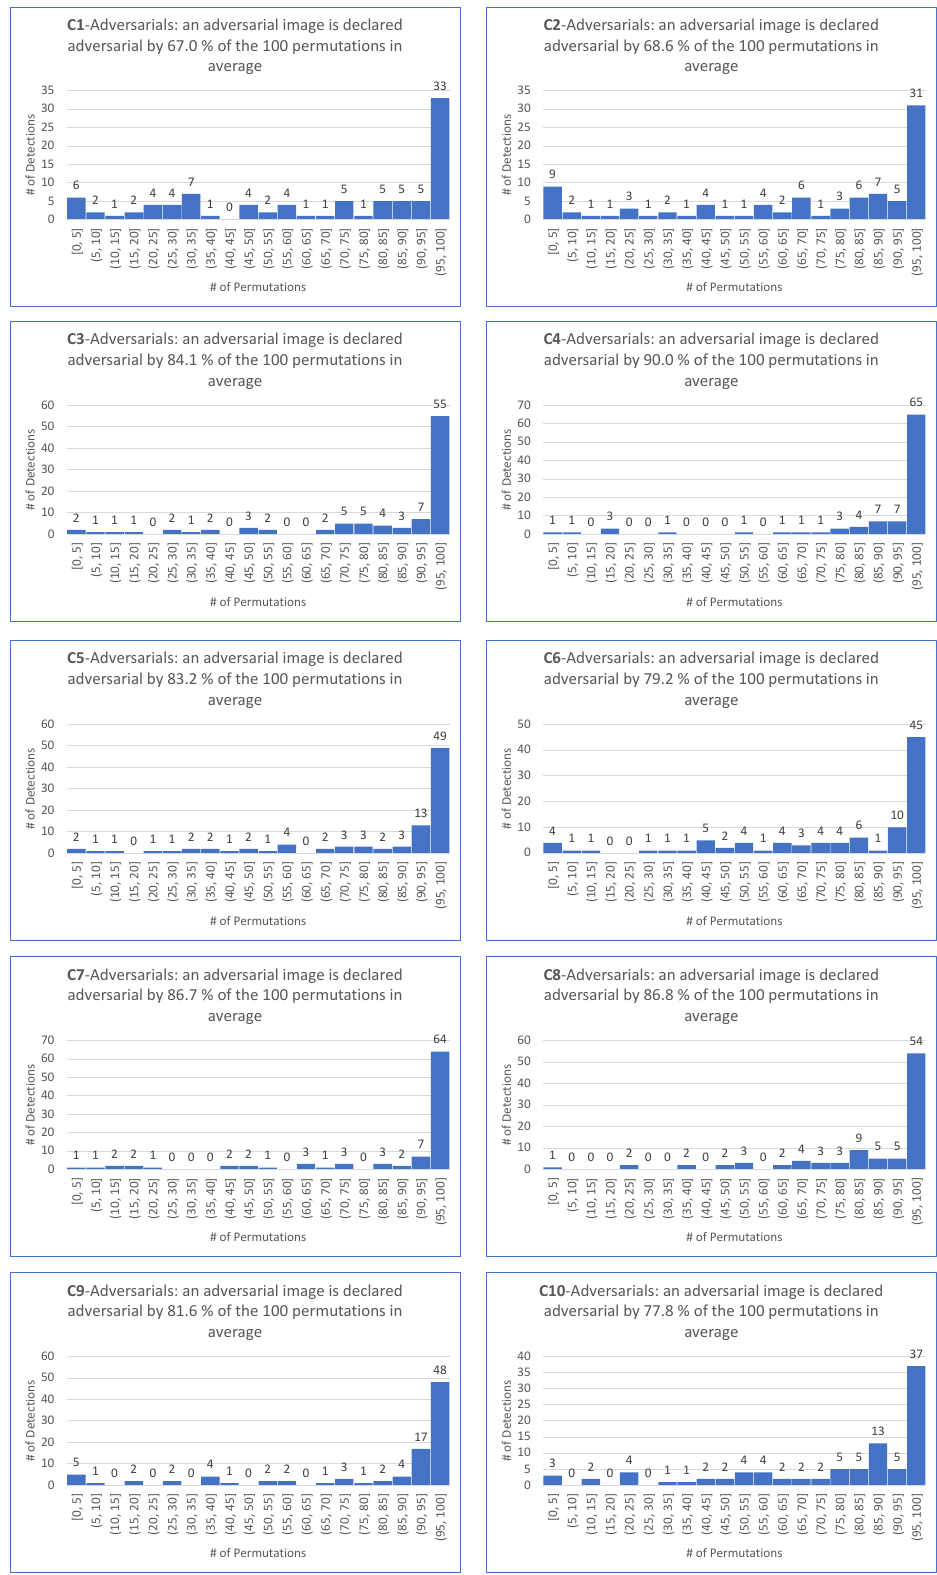
Figure A10. ShuffleDetect results for adversarial images generated by the PGD Inf-untargeted attack on C = C for 1 ≤ k ≤ 10 over 100